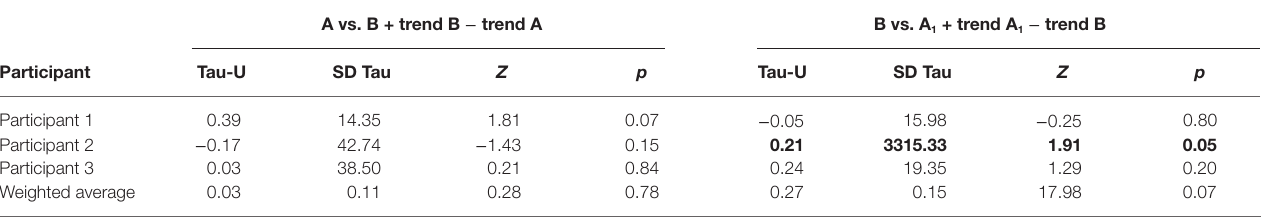
TABLE 3 | Tau-U calculations across phases for each participant.